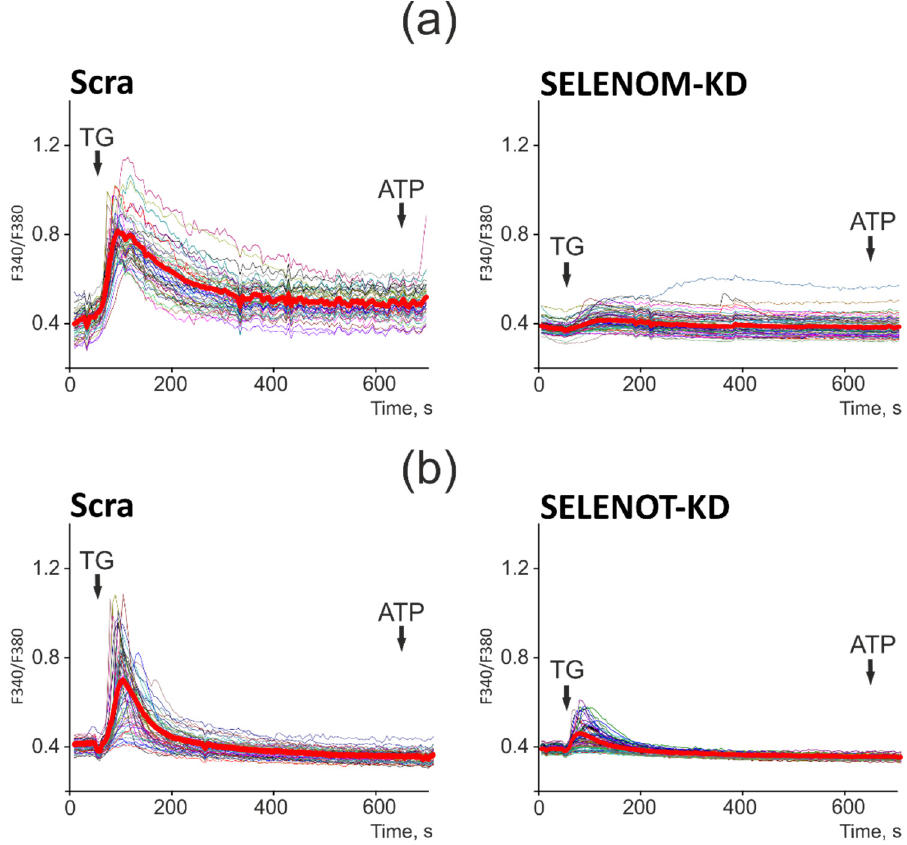
Figure 4. Effect of SELENOM-KD ( a ) and SELENOT-KD ( b ) on the Ca 2+ capacity of the endoplasmic reticulum. ( a , b ) Ca 2+ signals in the Scra, SELENOM-KD ( a ), and SELENOT-KD ( b ) experimental groups to the application of thapsigargin (TG, 10 mM) in a nominally calcium-free medium supple- mented with Ca 2+ chelator EGTA (0.5 mM). At the end of the experiment, 10 µM ATP was added as a test for the depletion of the ER Ca 2+ pool. Ca 2+ signals of cells in one experiment and their average value are presented. The number of cell passages used for experiments is 4.